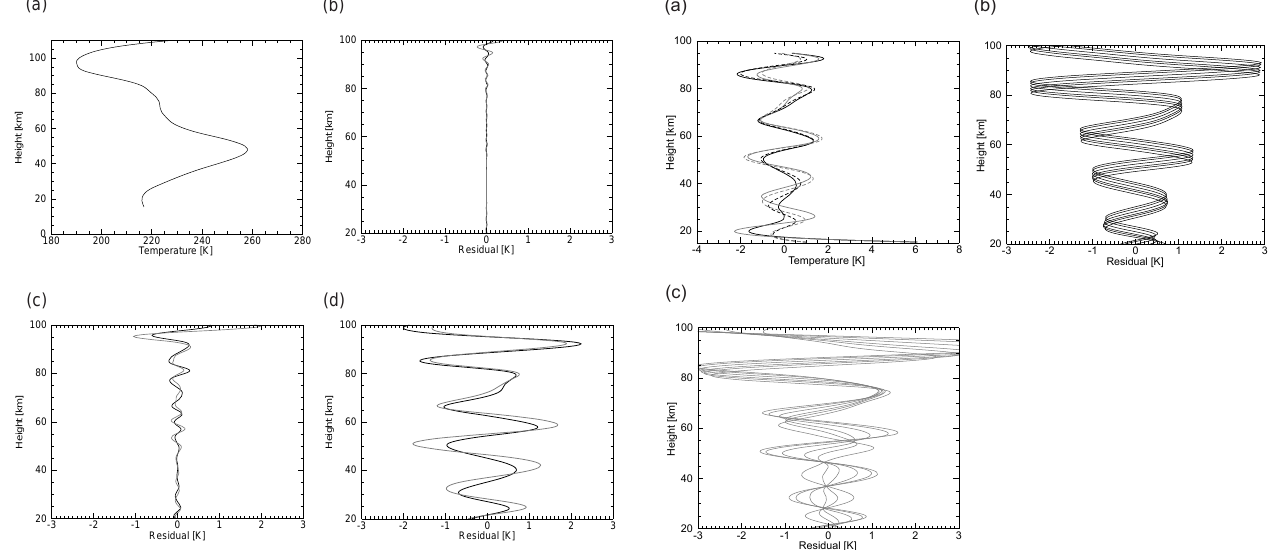
Figure 10. (a) Superposition of Fig. 9d (dashed lines, residuals af- ter detrending the CIRA temperature background without superim- posed gravity waves) and Fig. 7d (solid lines, difference between the original and the approximated background in the presence of gravity waves); (b) and (c) are residuals of the repeating (black) and non-repeating (grey) spline approximation (max. wavelength: 20km) of the CIRA temperature profile detrended between varying starting heights (15–20km) and